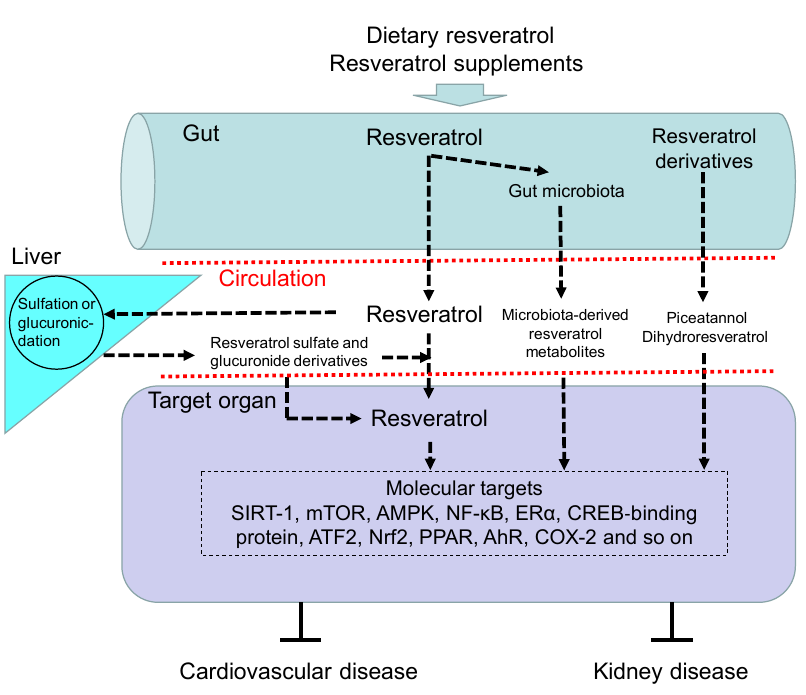
Figure 1. Overview of the absorption, metabolism, and targets of resveratrol. Upon oral intake, resveratrol and its precursors enter the gut and are partially metabolized by gut microbiota to produce microbiota-derived resveratrol derivatives and resveratrol. Like resveratrol, other resveratrol derivatives like piceatannol and dihydroresveratrol can also be absorbed into the blood circulation. Free resveratrol is conjugated in the liver, from where conjugated forms can return to the intestine. Resveratrol glucuronidation and sulfation in the liver to form resveratrol glucuronide and sulfate derivatives. After delivery to the target organ, resveratrol can be deconjugated to stimulate a biological response via regulation of its molecular targets, by which it benefits against cardiovascular disease and kidney disease. AhR = aryl hydrocarbon receptor. SIRT-1 = silent information regulator-1. mTOR = mammalian target of rapamycin. NF- κ B = nuclear factor-kappa B. AMPK = adenosine monophosphate-activated protein kinase. ER α = estrogen receptor α . ATF2 = activating transcription factor 2. Nrf2 = nuclear factor (erythroid-derived 2)-like 2. PPAR = peroxisome proliferator-activated receptor. COX-2 =